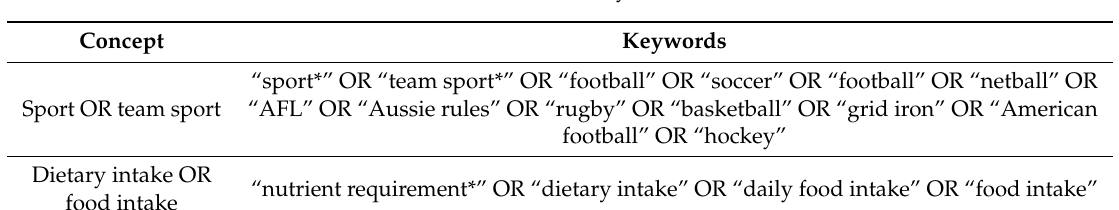
Table 2. Table of